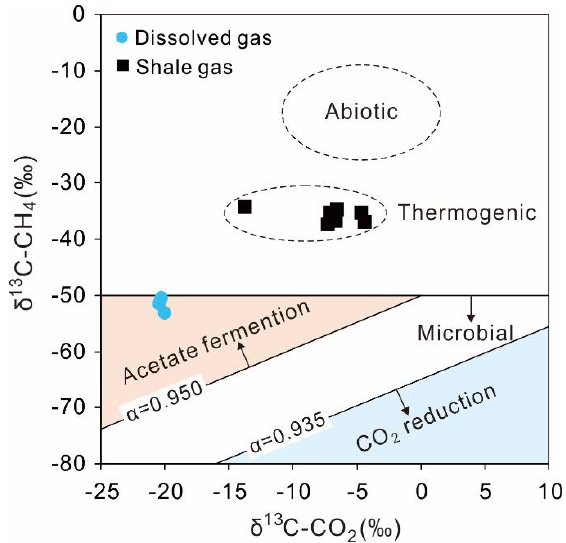
Figure 8. The plot of δ 13 C-CH 4 versus δ 13 C-CO 2 with the dissolved gas of shallow groundwater in Xishui and shale gas from Weiyuan. The abiotic range is from Ueno et al. (2006) [104] The lines of α = 0.935 and α = 0.950 stand for the boundary line of CO 2 reduction and acetate fermentation, respectively [70].